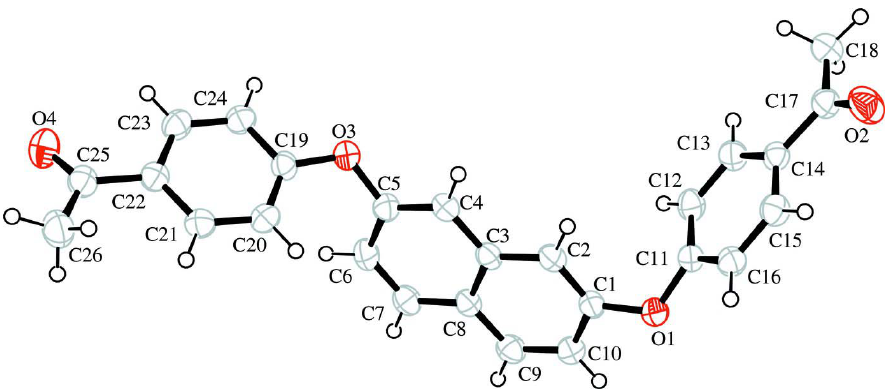
Figure 1 Molecular structure of (I), with the atom-labeling scheme and displacement ellipsoids drawn at the 50% probability level.